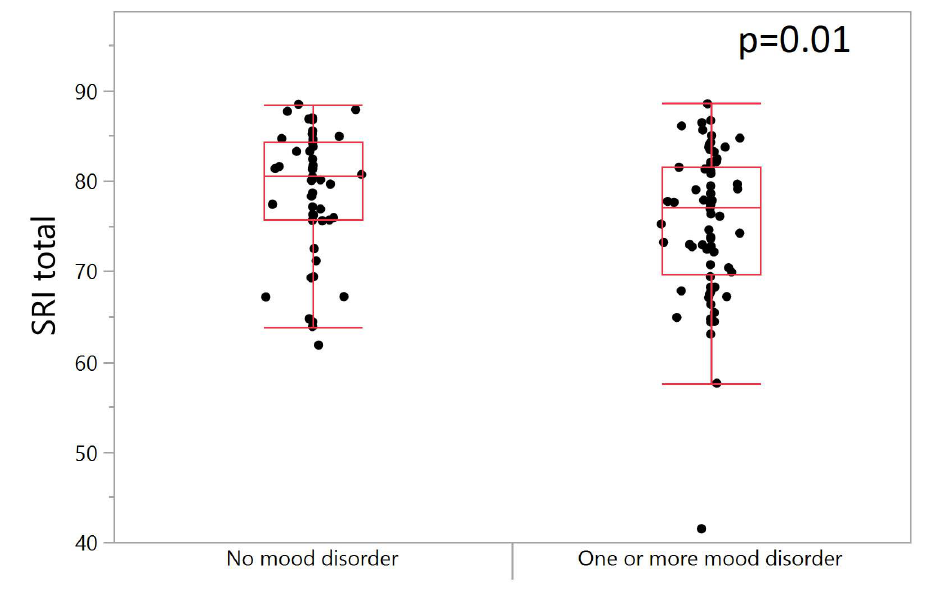
Figure 3. One-way plot of total SRI between participants with no mood disorder and those with one or more mood disorders. T -test shows a significant di ff erence in total SRI between individuals with and without one or more mood disorder ( p = 0.01, N = 120). Average total SRI for individuals with no mood disorders (N = 50) is slightly higher than that for individuals with one or more mood disorders (N =